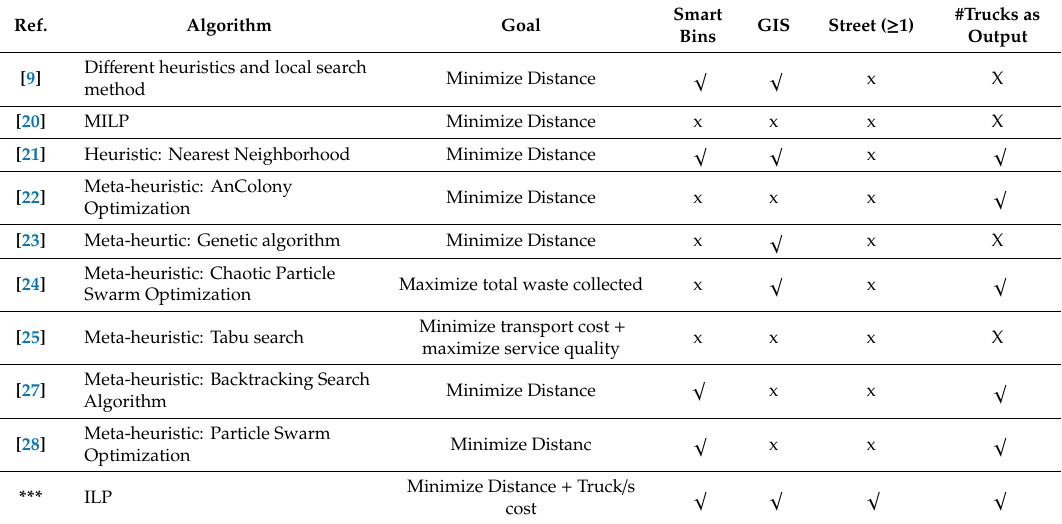
Table 1. Comparison of the main features of algorithms reviewed in state of art.